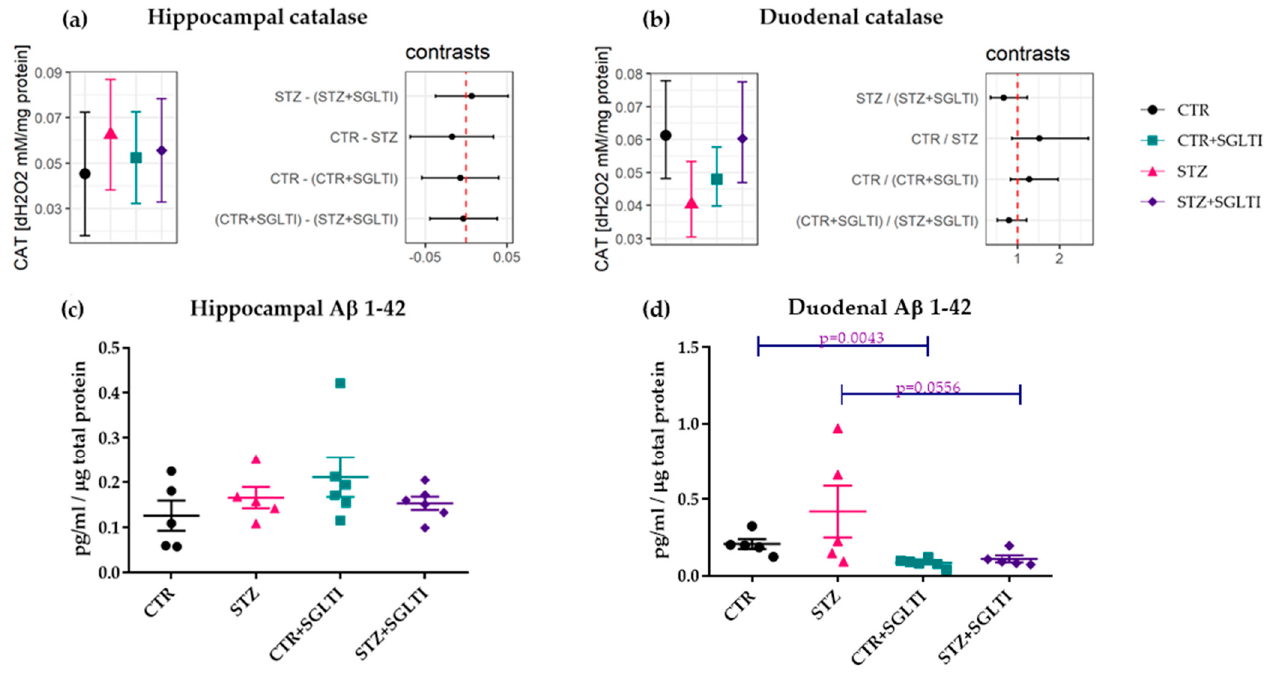
Figure 6. Analysis of hippocampal and duodenal soluble amyloid β (A β ) 1-42 peptide content and catalase activity following 2 months of phloridzin treatment. The results of ( a ) hippocampal and ( b ) duodenal catalase activity are presented as least square mean estimates with 95% con fi dence interval ( left ) and estimates of contrasts (di ff erences) with 95% con fi dence interval ( right ). The dependent variable (catalase activity) was adjusted for protein concentration (loading control) and baseline H 2 O 2 . The results of ( c ) hippocampal and ( d ) duodenal A β 1-42 level are presented as mean ± SD with individual animal data and analysed by Kruskal–Wallis 1-way ANOVA with Wilcoxon signed rank tests for between-group comparisons. CTR—control group; STZ—streptozotocin-treated group; CTR+SGLTI—control group treated with phloridzin; STZ+SGLTI—streptozotocin-treated group treated with phloridzin.